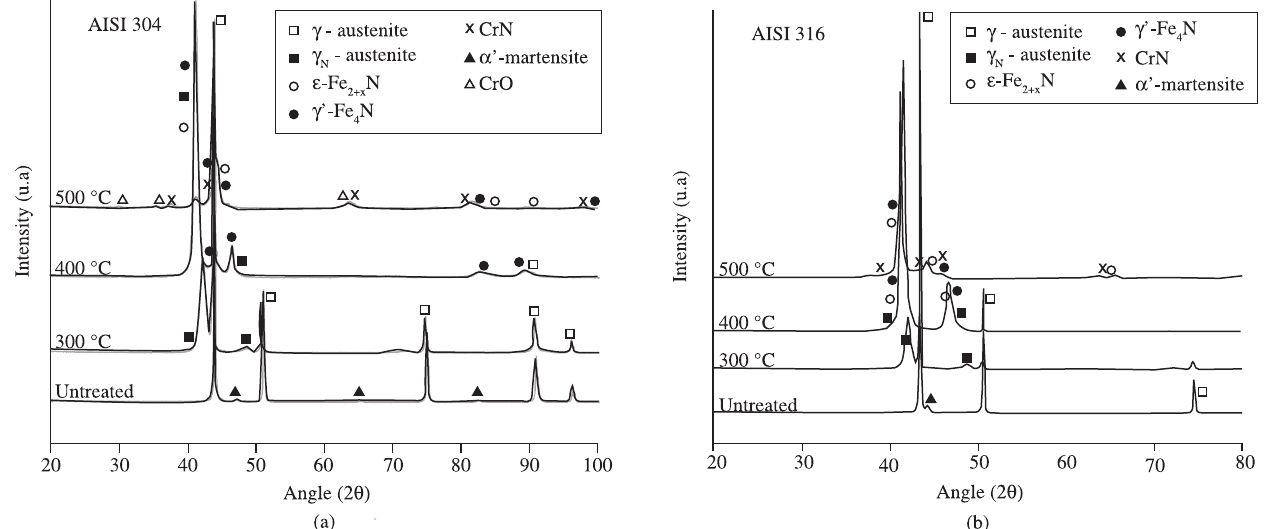
Figure 1. X ray diffractions patterns for samples of AISI 304 (a) and AISI 316, (b) both untreated and nitrided at 300, 400 and 500